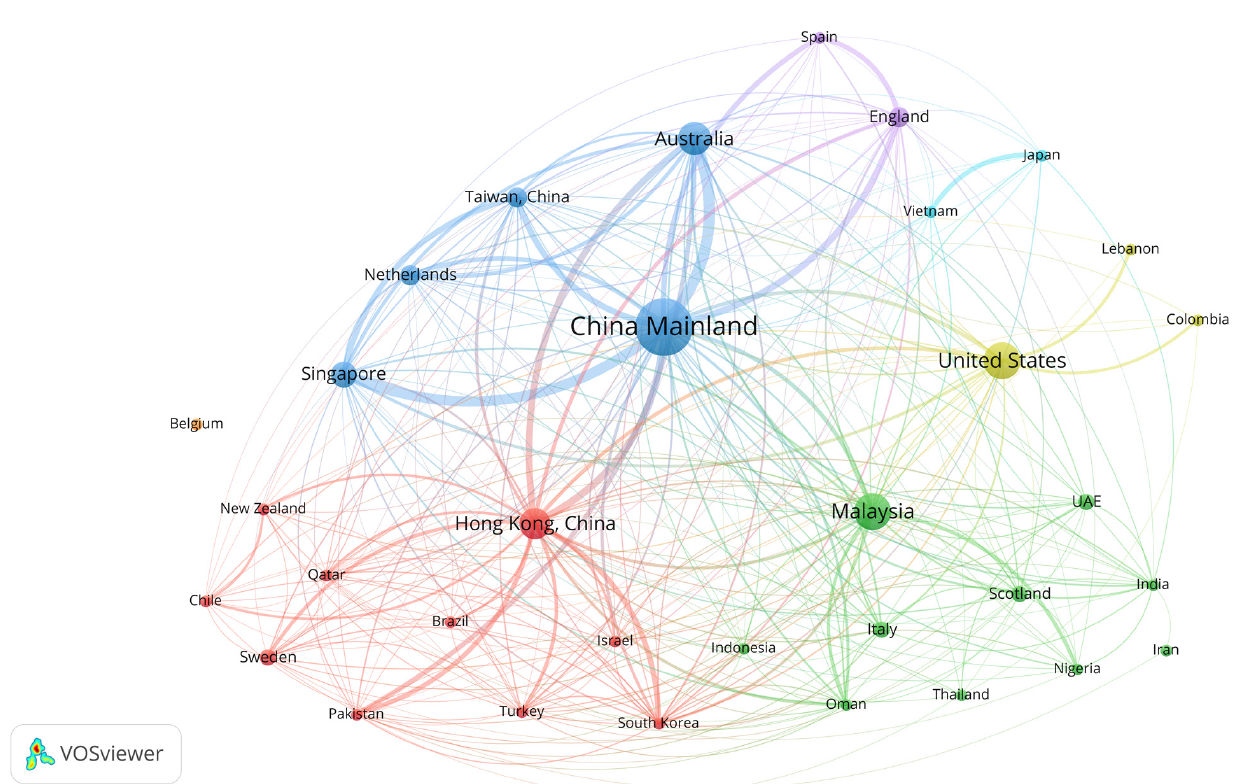
Figure 5. Map of countries/regions engaged in CGCC